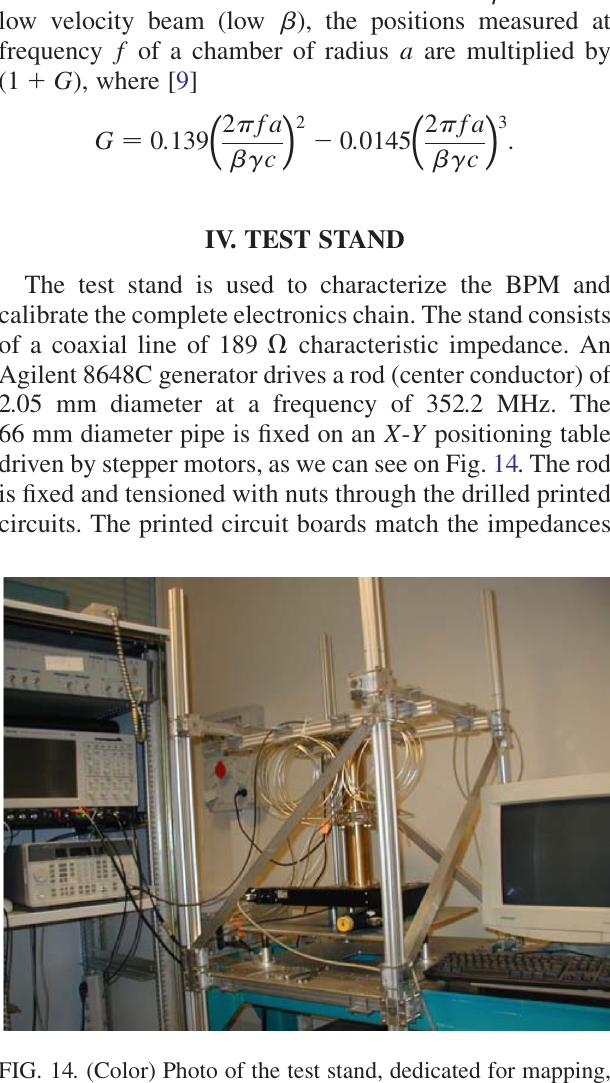
FIG. 14. (Color) Photo of the test stand, dedicated for mapping, characterization, and